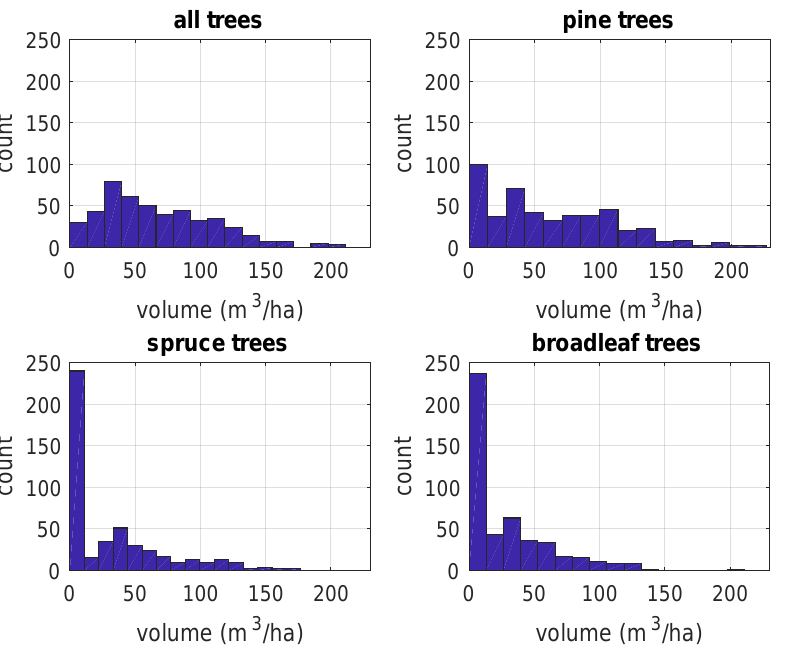
Figure 2. Histograms describing tree volume distributions in the Aland research area. Volumes of 0–10 m 3 /ha of spruce and broadleaf trees are of high frequency in sample sites, whereas the most frequent volume of all trees in sample sites is 20–30 m 3 /ha. The average volumes for all, pine, spruce and broadleaf trees are 67.4, 61.5, 30.5 and 26.7 m 3 /ha respectively. Table 1. List of the top ten predictor features found for the target variables: growing stock tree volume (all, pine, spruce, broadleaf trees) in the work by [44]. In the table H stands for height above ground. The optimal features were selected via greedy forward selection method see, e.g., [49]. Volume All